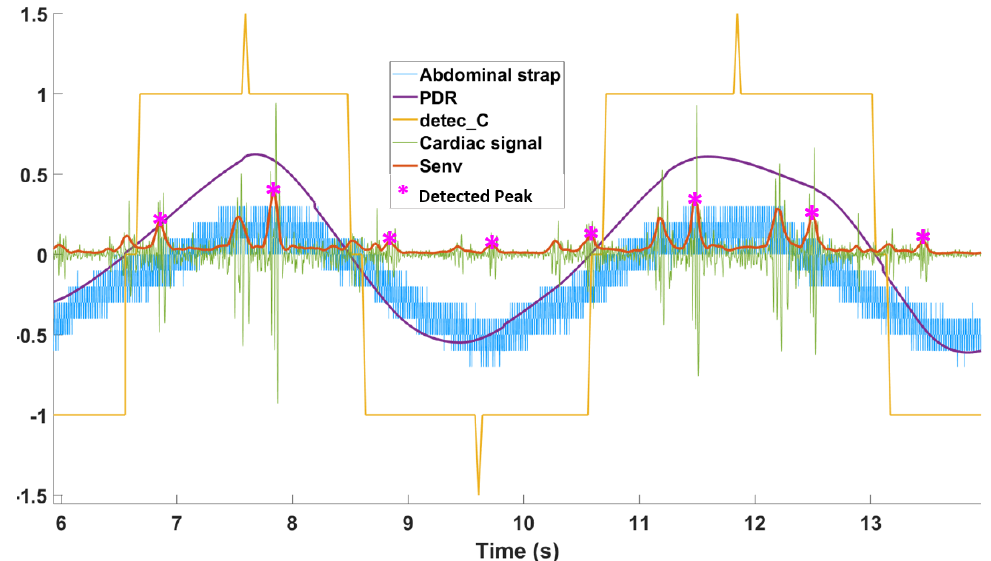
Figure 8. PDR. The extracted cardiac signal is shown in green, and the processed envelogram is in red. Only one cardiac peak (S1/S2) detected ( pink star ) for each cardiac cycle. Positive (Negative) of the PDR detection result ( yellow ) indicates the inspiration (expiration) as reference